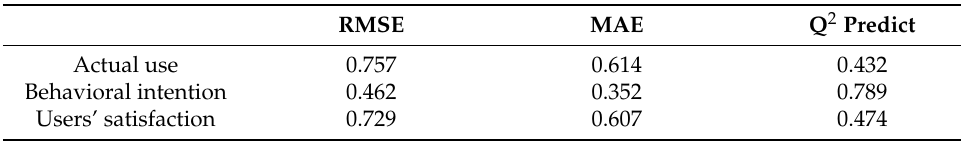
Table 7. Predictive performance for the PLS path